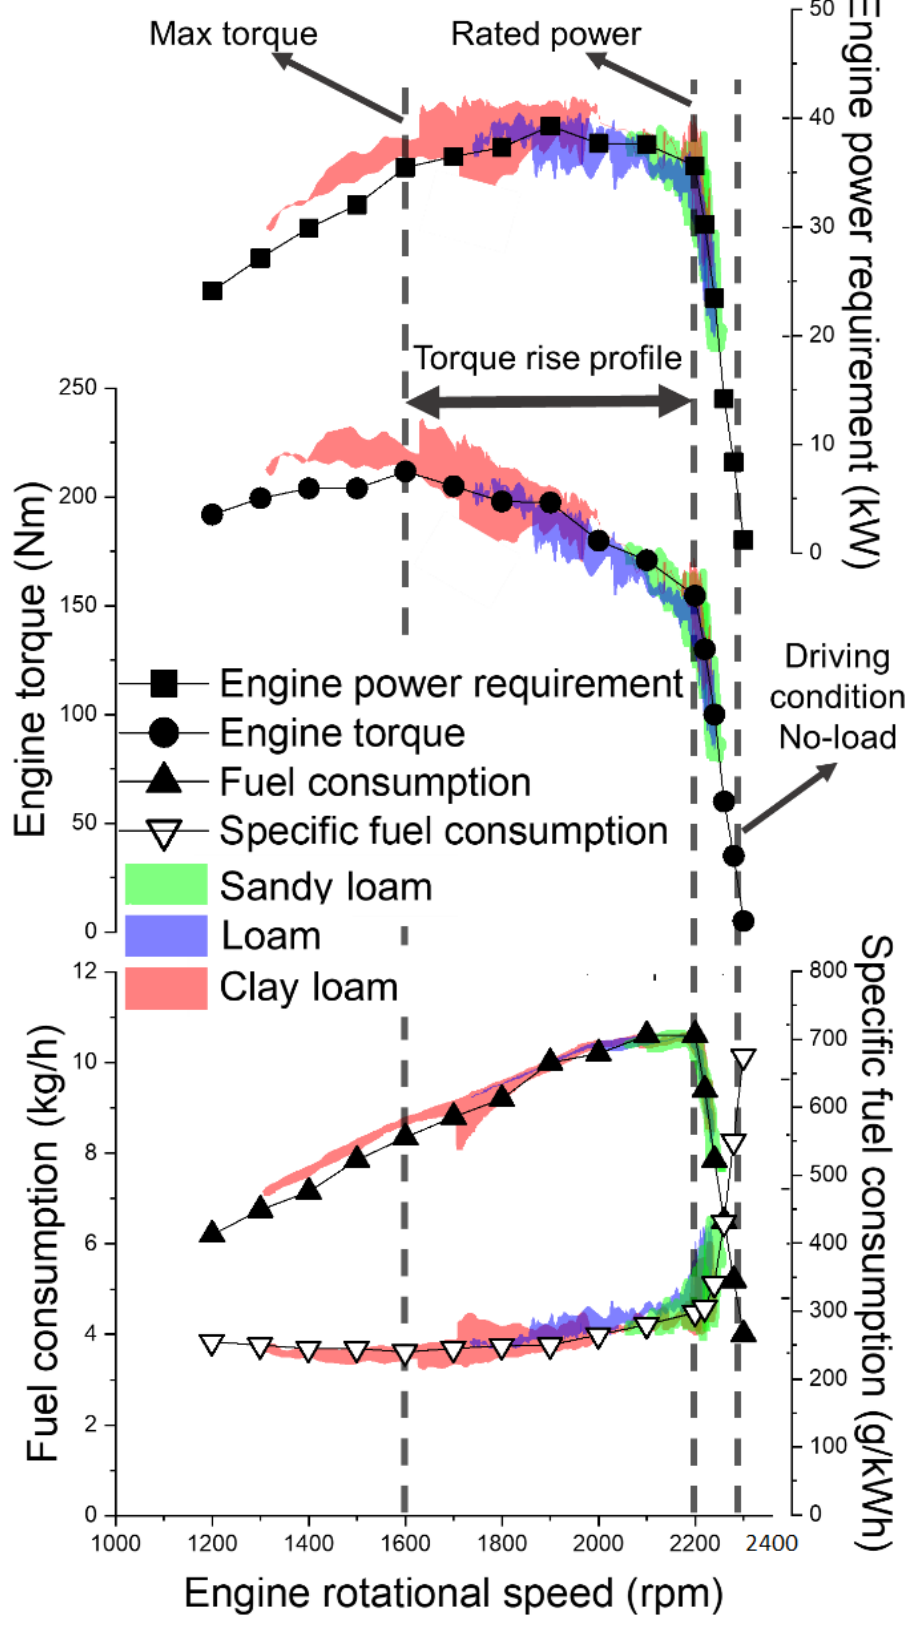
Figure 11. Comparative analysis of measurement data on tractor engine performance curve.